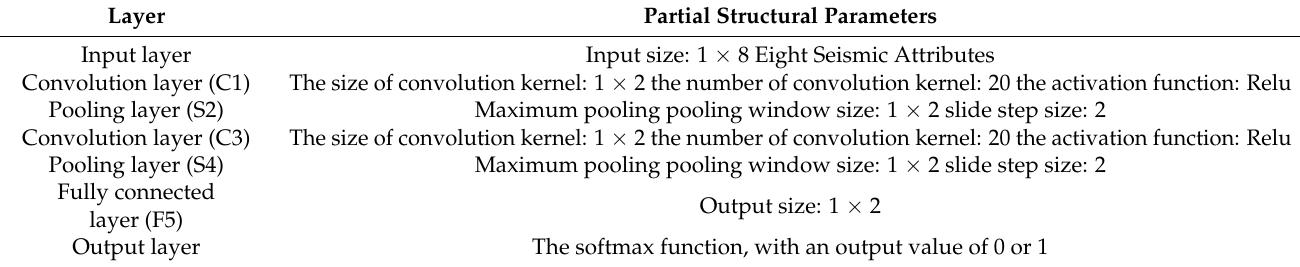
Table 4. Structural parameters of Model